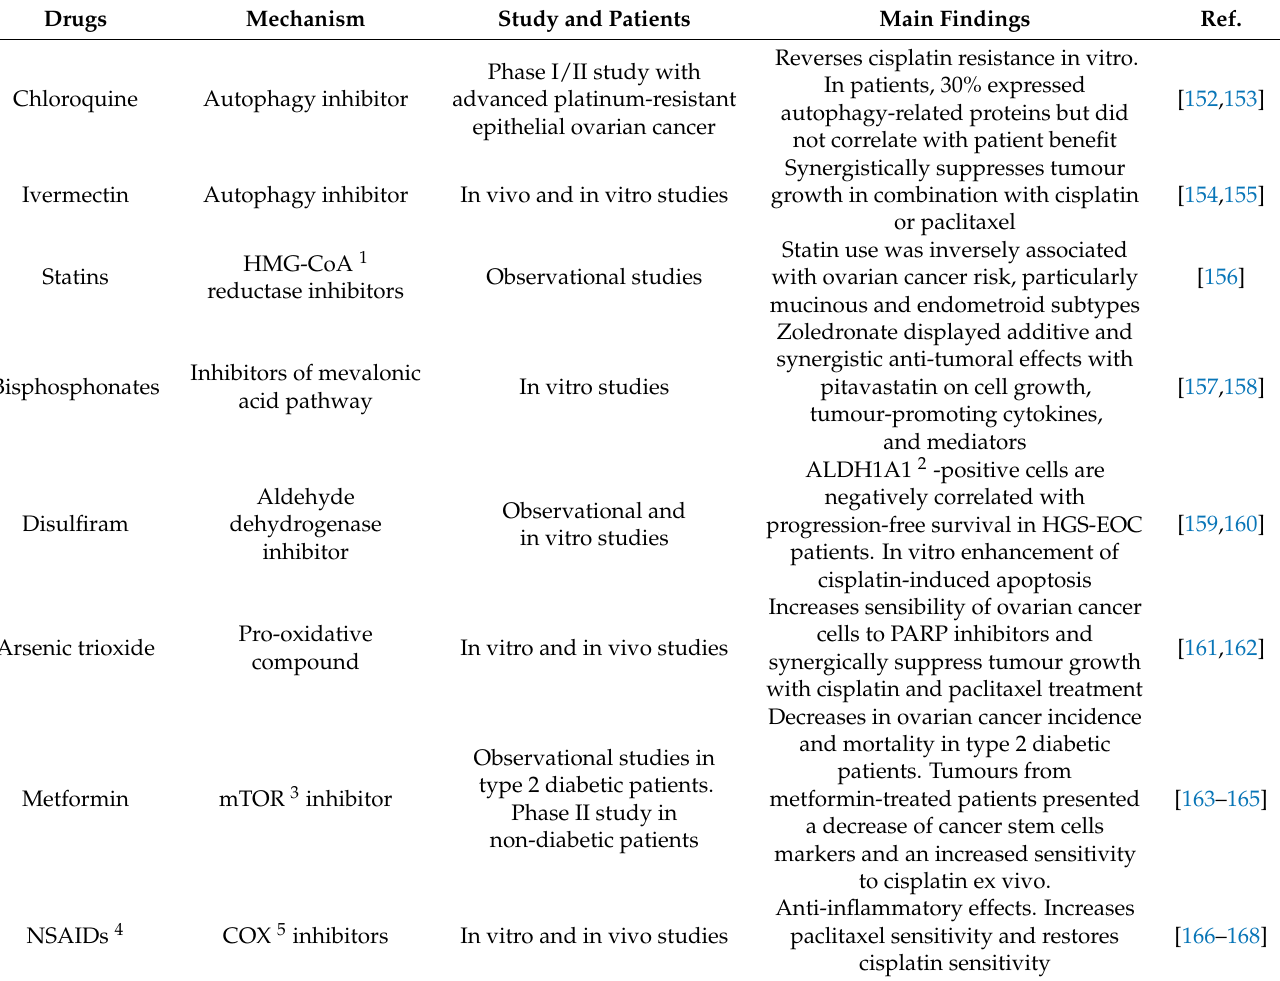
Table 4. Summary of the main findings of studies using repurposing drugs for ovarian cancer